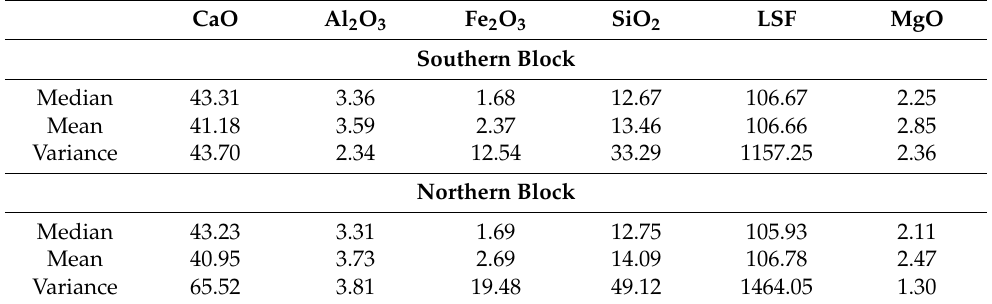
Figure 4. LSF and MgO maps of northern and southern blocks. ( a ) LSF of the southern block; ( b ) LSF of southern block; ( c ) MgO of southern block; ( d ) MgO of south blockern. Table 1. The exploratory data analysis of the south block and north block of the case study